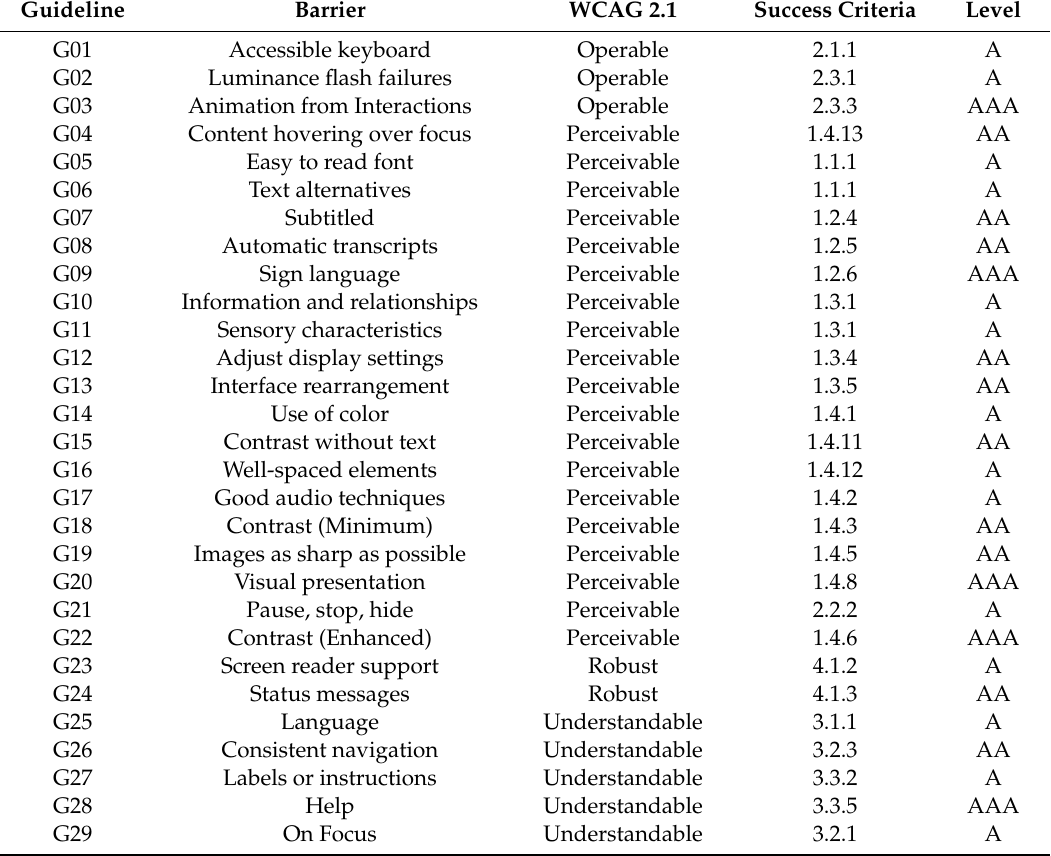
Table 2. Guidelines for evaluating accessibility in serious